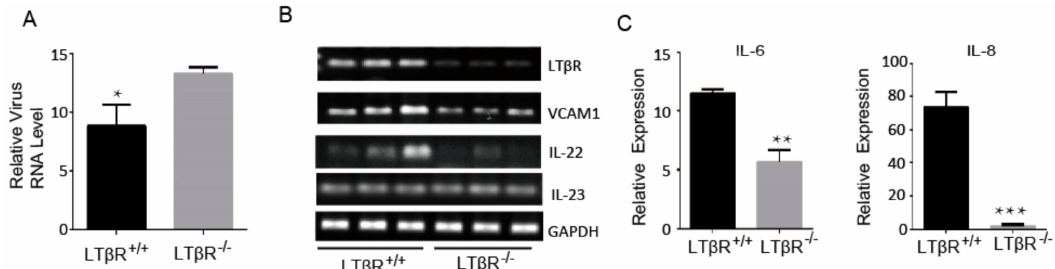
Figure 5. Effect of LT β R on porcine epidemic diarrhea virus (PEDV) infection of IPEC-J2 cells. ( A ) LT β R +/+ and LT β R − / − cells were challenged with PEDV CV777 strain (at a multiplicity of